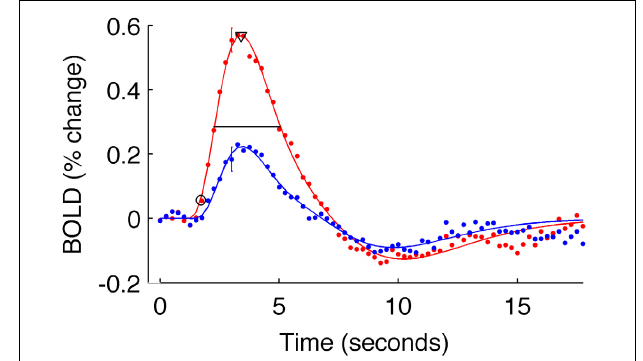
FIGURE 3 | Estimated HRFs and fit parameters for one typical subject. Dots are BOLD data for subject 9, averaged within active voxels in V1, for the short-ISI experiment. Color indicates stimulus contrast (blue 5%, red 90%). Error bars show ± one standard error of the mean across voxels for a typical timepoint. Solid line is the fit HRF for these data, used to calculate HRF timing parameters. Onset latency (circle), time to peak (triangle), and FWHM (horizontal line) are